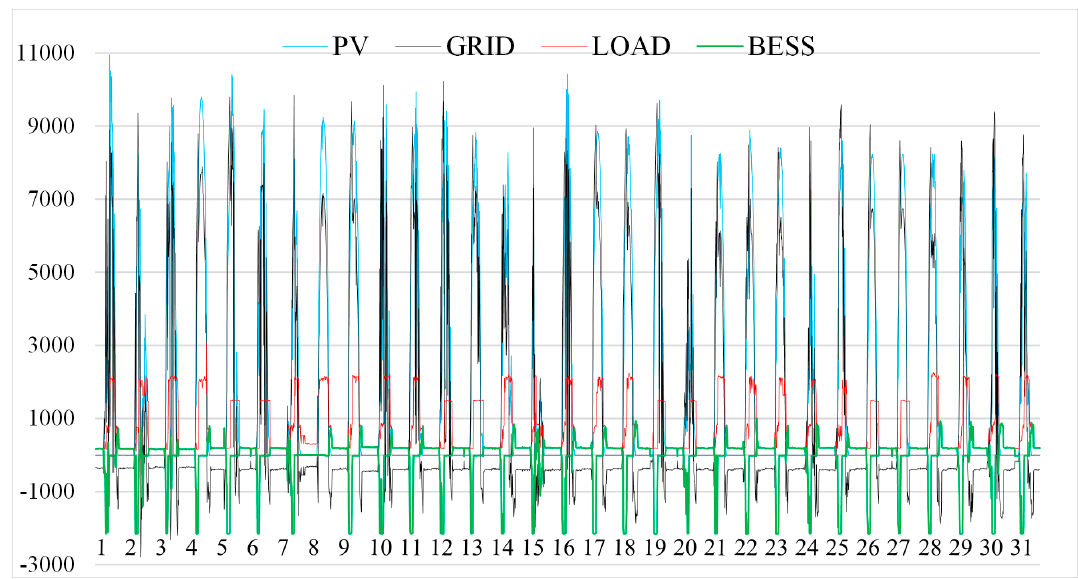
Figure 11. LAMBDA historical data by the Com’X 510 energy server in October 2019 (in Watts).